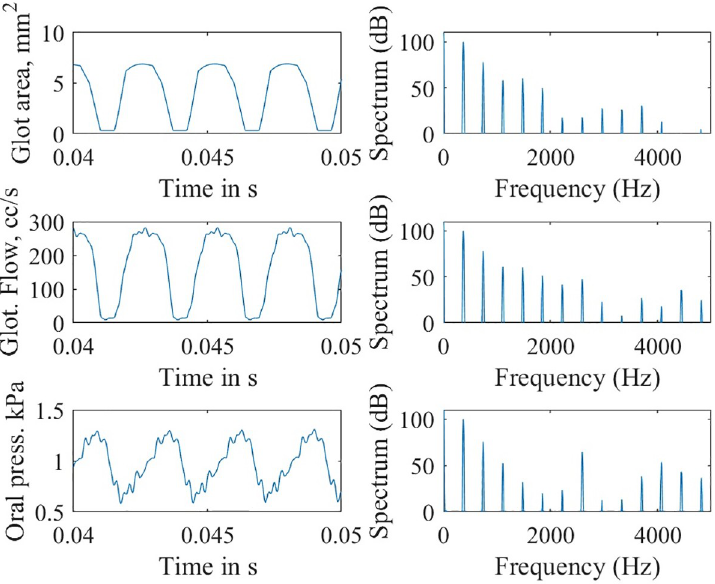
Fig 10. Waveforms and spectra for the simulation with epilaryngeal airway not allowed to